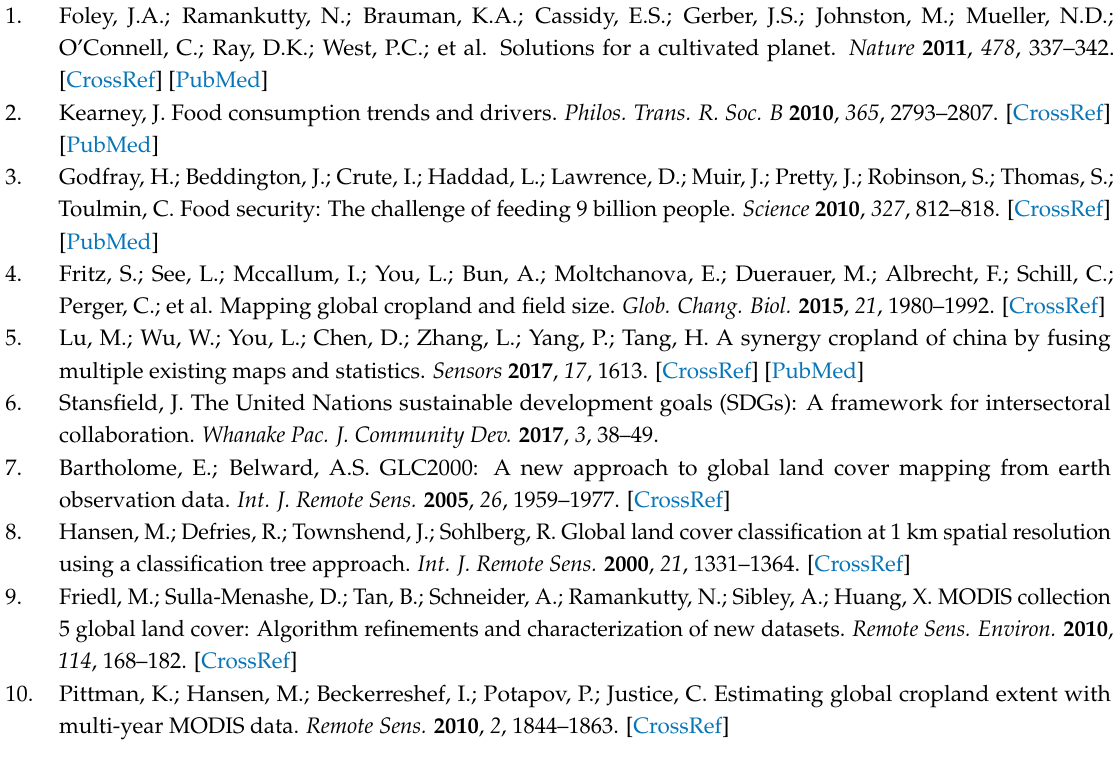
Figure S1: Distribution of training and validation samples, Table S1: The score table of Modified Fuzzy Agreement Scoring method (5 input maps); Table S2: Cropland definitions and modified cropland percentages of input maps; Table S3: Provincial statistical data of